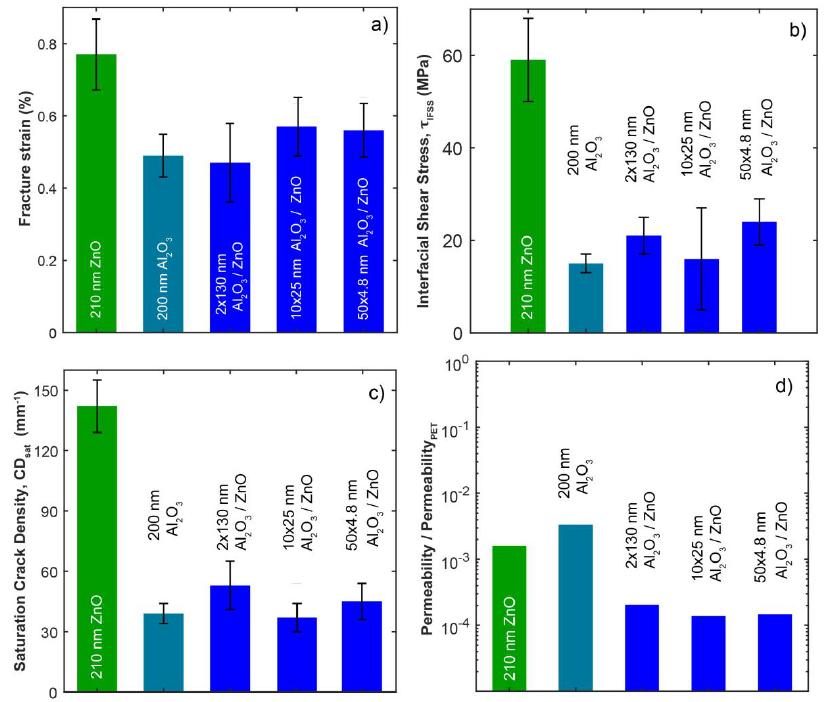
Figure 8. Graphs of ( a ) fracture onset strain, ( b ) interfacial shear stress, and ( c ) saturation crack density versus bilayer thickness for the roughly 250 nm thick nanolaminate coatings and the single (single compound) films ZnO and Al 2 O 3 on PET, ( d ) Permeability of O 2 of the single ZnO and Al 2 O 3 and the 130, 25, and 4.8 nm bilayer thickness nanolaminate coatings on PET compared to the permeability of the 175 µ m thick PET. All the nanolaminates were about 250 nm thick in total (see Table S1). Note the logarithmic scale for ( d